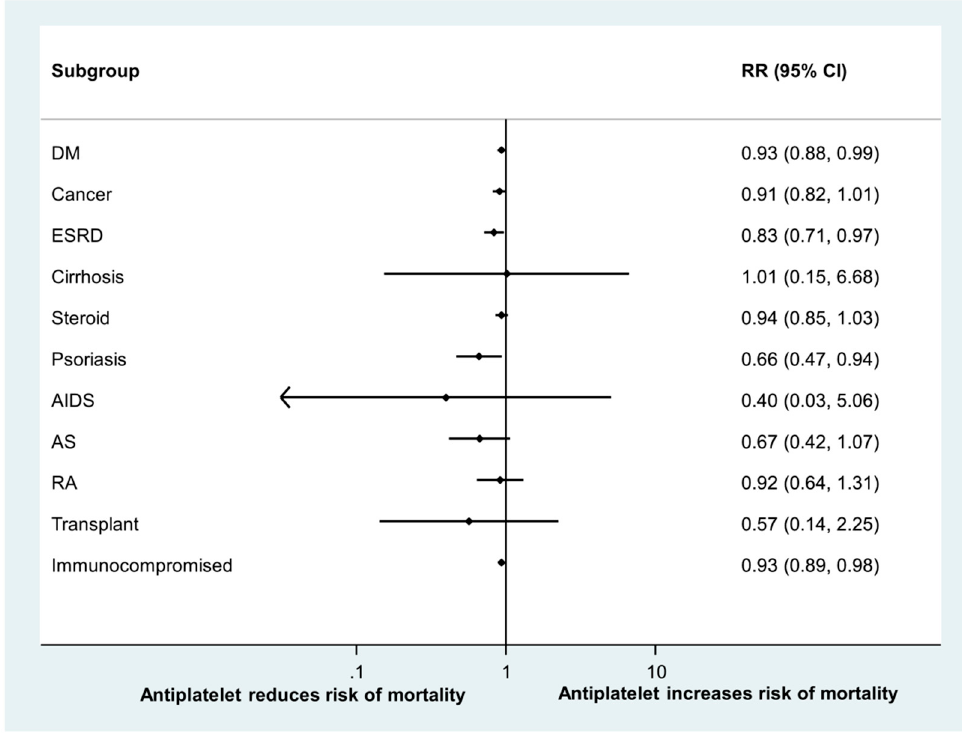
Figure 2. Forest plot of the association between antiplatelet agent use and survival among different groups of patients. Abbreviations: AIDS, acquired immunodeficiency syndrome; AS, ankylosing spondylitis; DM, diabetes mellitus; ESRD, end-stage renal disease; and RA, rheumatoid arthritis